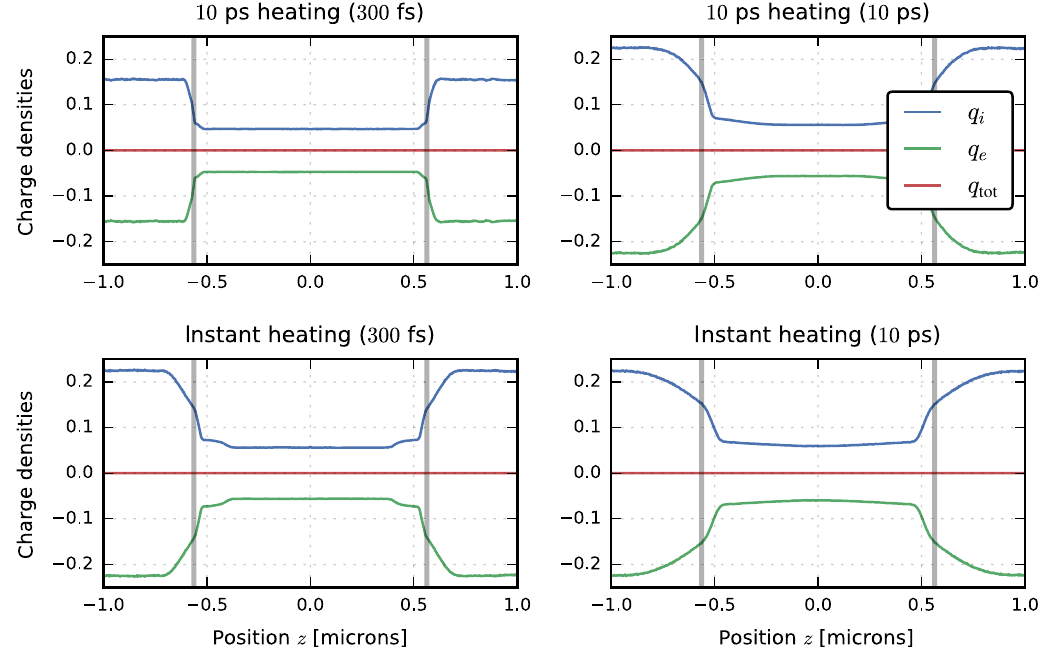
FIG. 7. Charge densities. The ionic (upper, blue line), electronic (lower, green line), and total (middle, red line) charge densities are ≡ Z ≡ − en en shown, denoted as q , q , and the sum q , respectively. The electronic charge density results from the macroscale i i e i e tot solver and is used to construct the mesoscale interaction potentials. The full (unfolded) cell is shown with both interfaces; the locations of the original interfaces are denoted by vertical grey lines. The DT fuel is in the center region between the grey lines, whereas the plastic ablator material is in the left and right regions that adjoin the boundaries. The top and bottom rows correspond to slow and rapid heating, respectively, and the left and right columns show early and late (300 fs and 10 ps) times, respectively. Strong quasineutrality is seen in all